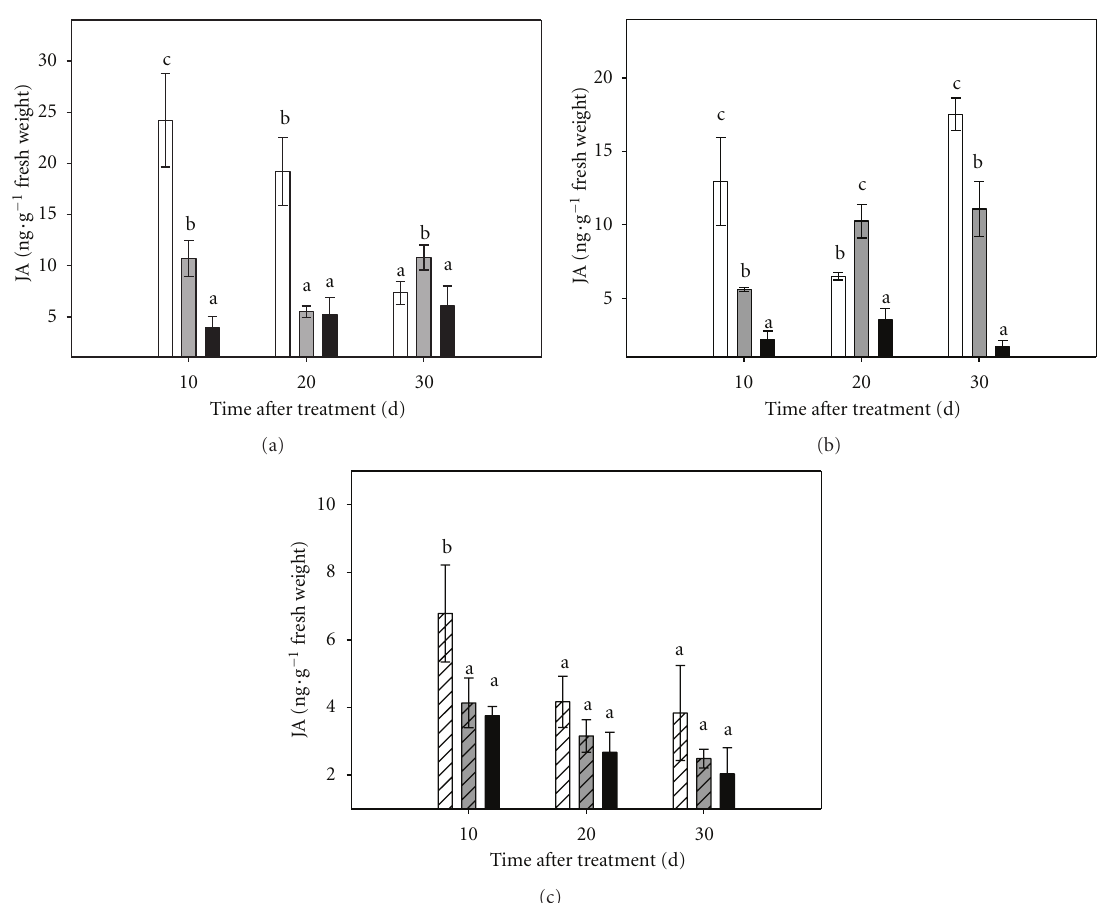
Figure 10: E ff ect of osmotic stress on JA content in Carrizo citrange plants cultured in vitro . (a): aerial part of intact plants; (b): root tissue of intact plants; (c): micropropagated shoots. Control plants (white bar), plants cultured under moderate (grey bar) or severe (black bar) osmotic stress conditions. Each point corresponds to the average ± standard error of six independent determinations. Di ff erent letters denote statistical significance at P <